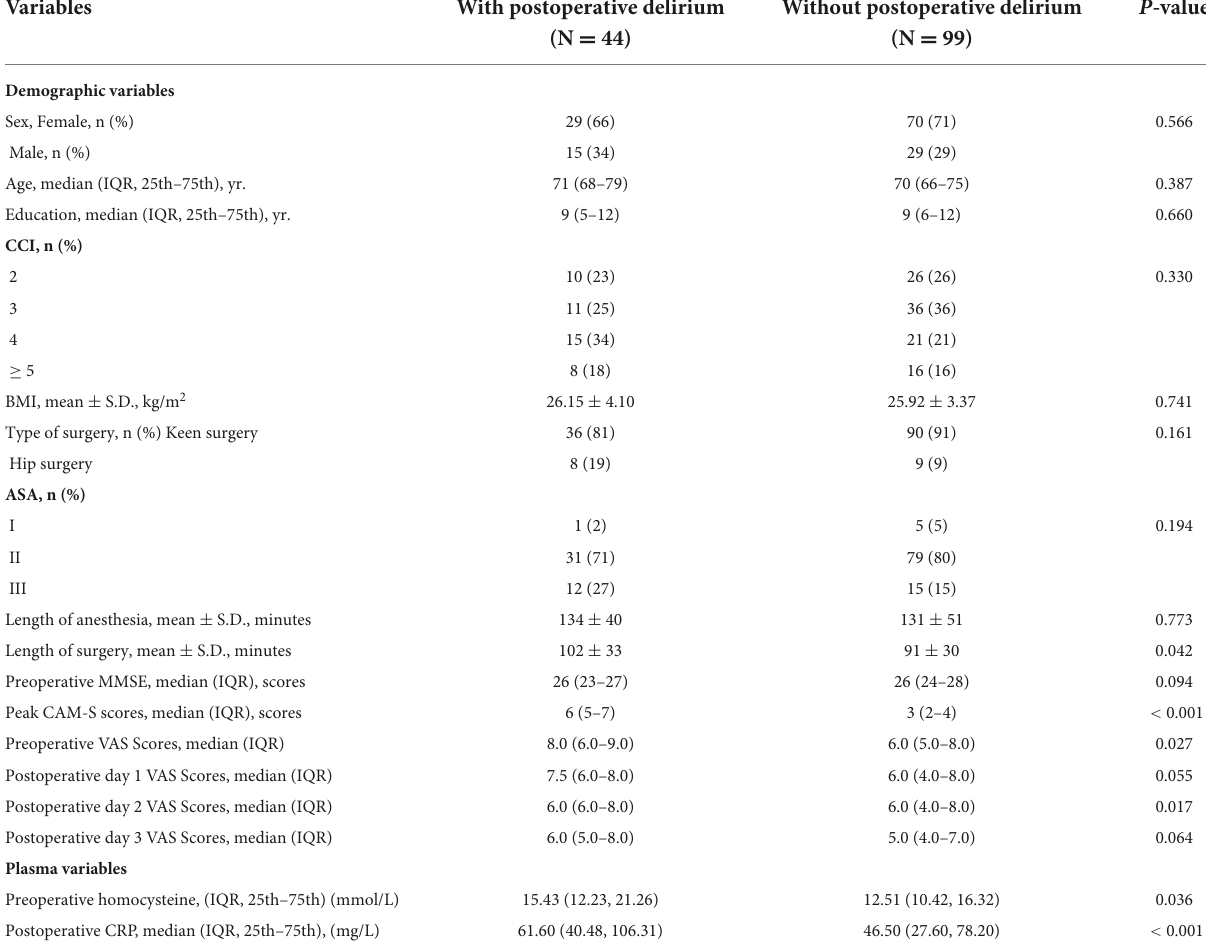
TABLE 1 Clinical characteristics of the participants with and without postoperative